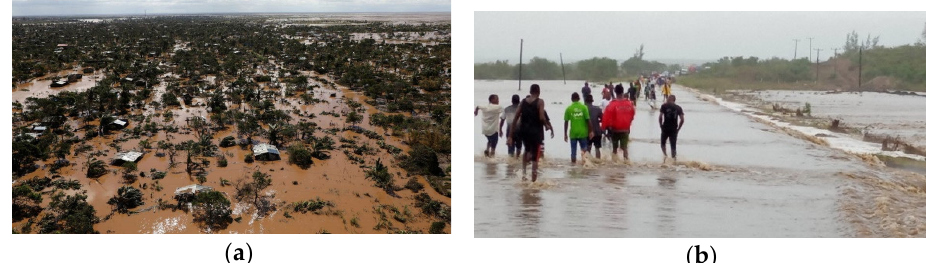
Figure 3. Images from ( a ) Cyclone Idai: Flooded homes are seen after Cyclone Idai in Buzi district outside Beira, Mozambique, 21 March 2019. REUTERS/Siphiwe Sibeko/File Photo; and ( b ) Cyclone Kenneth: Flooding in Mozambique northern Cabo Delgado province following Cyclone Kenneth landfall on Thursday, April 25 © UNDP Mozambique/Emidio Josine.